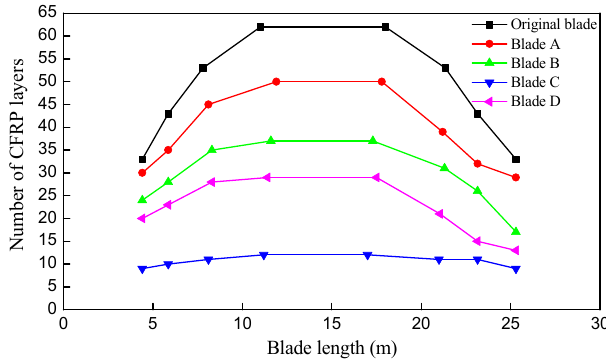
Figure 20. Comparison of GFRP material layup of the spar cap.